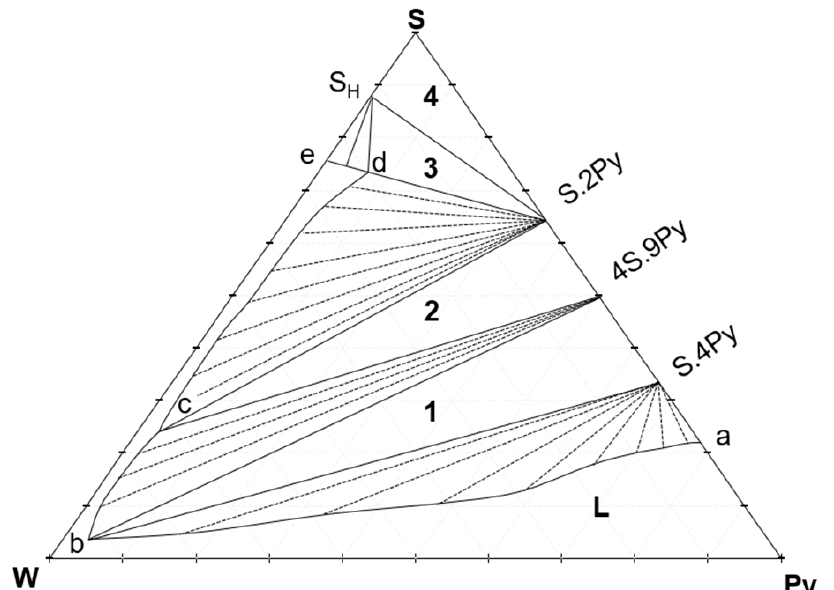
Figure 2. Ternary phase diagram of the AgClO 4 –pyridine–H 2 O system [3] (W—water, Py—pyridine, S—salt (AgClO 4 )). Areas of invariant equilibria are marked with letters a-e